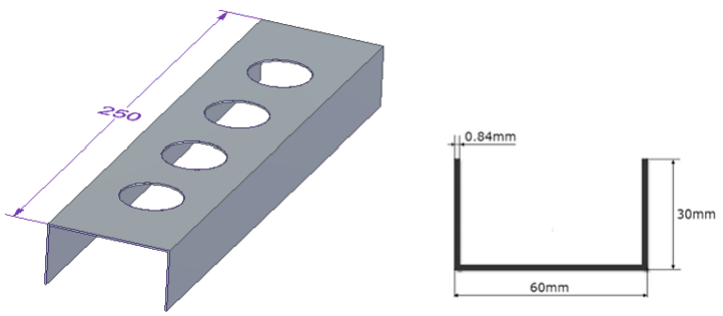
Figure 2. Geometric parameters of the tested profile. Table 1. Mechanical properties of a CFRP lamina.